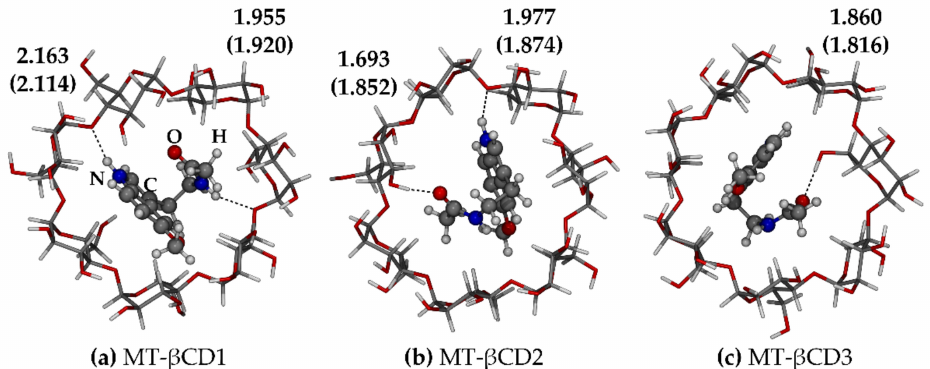
Figure 8. xTB-GFN2 optimized geometries of the studied MT- β CD inclusion complexes. Bond length